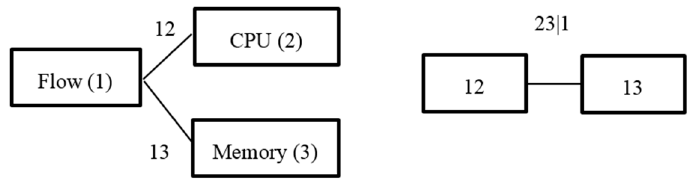
Figure 14. C-Vine decomposition of three variables.